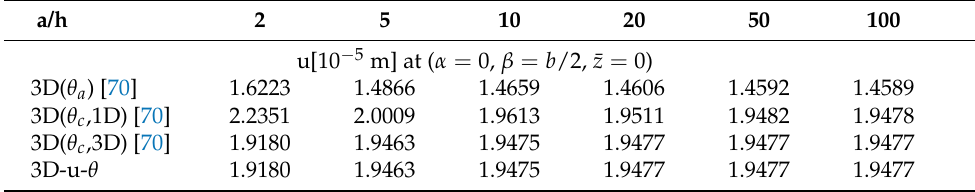
Figure 4. First benchmark, displacements and stresses for a thick ( a / h = 10) simply supported sandwich square plate with FGM ( p = 0.5) core obtained via the 3D-u- θ model. Maximum amplitudes: w and σ zz at ( a /2, b /2); u and σ α z at (0, b /2). Table 3. First benchmark, simply supported sandwich square plate with FGM ( p = 0.5) core. Sovra- temperature imposed as Θ t = + 0.5 K and Θ b = − 0.5 K for m = 1 and n = 1. 3D uncoupled thermoelastic models from [70]. The new 3D coupled thermoelastic solution is 3D-u- θ . a/h